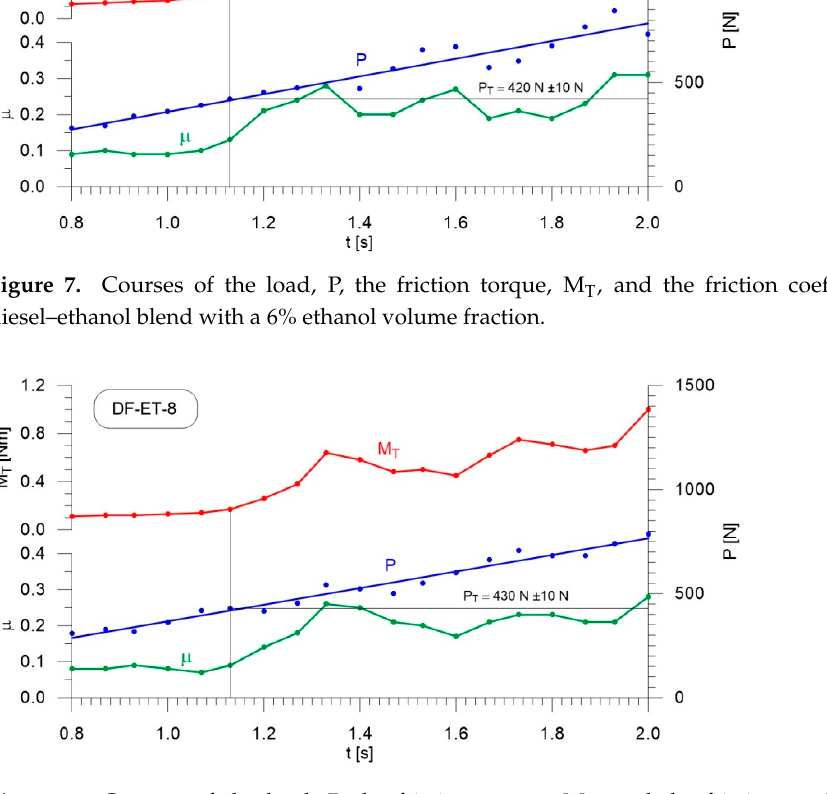
Figure 8. Courses of the load, P, the friction torque, M T , and the friction coefficient, µ, for diesel–ethanol blend with an 8% ethanol volume fraction.